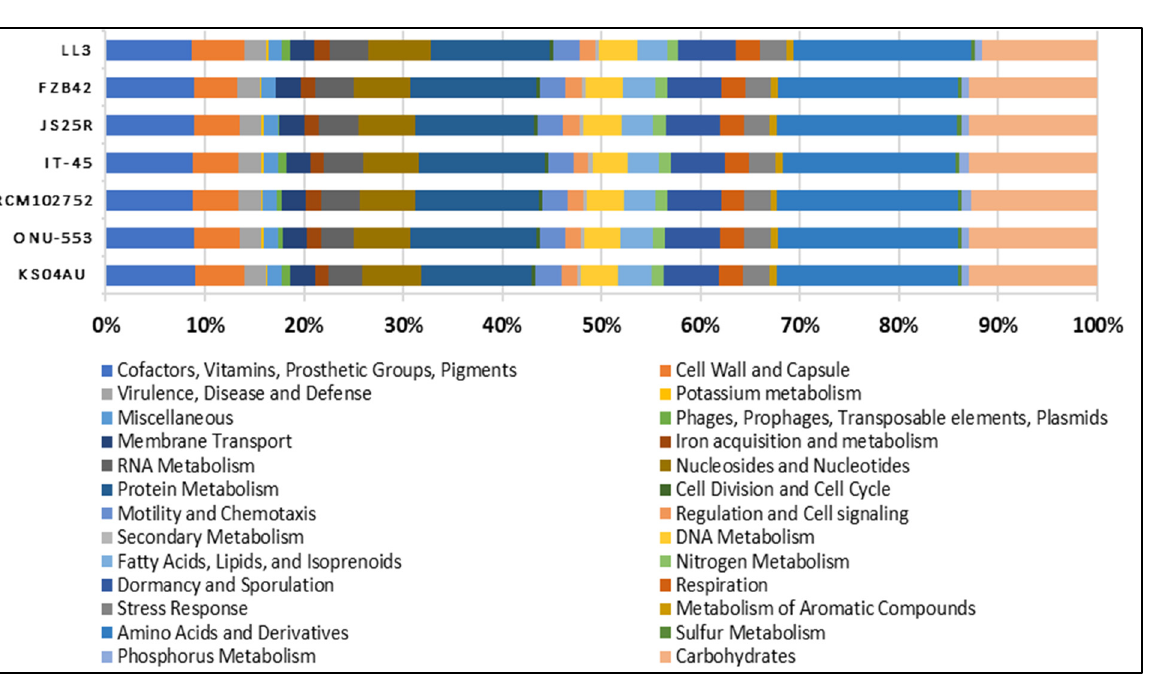
Table 4. Prophage regions found in Bacillus velezensis KS04AU genome.